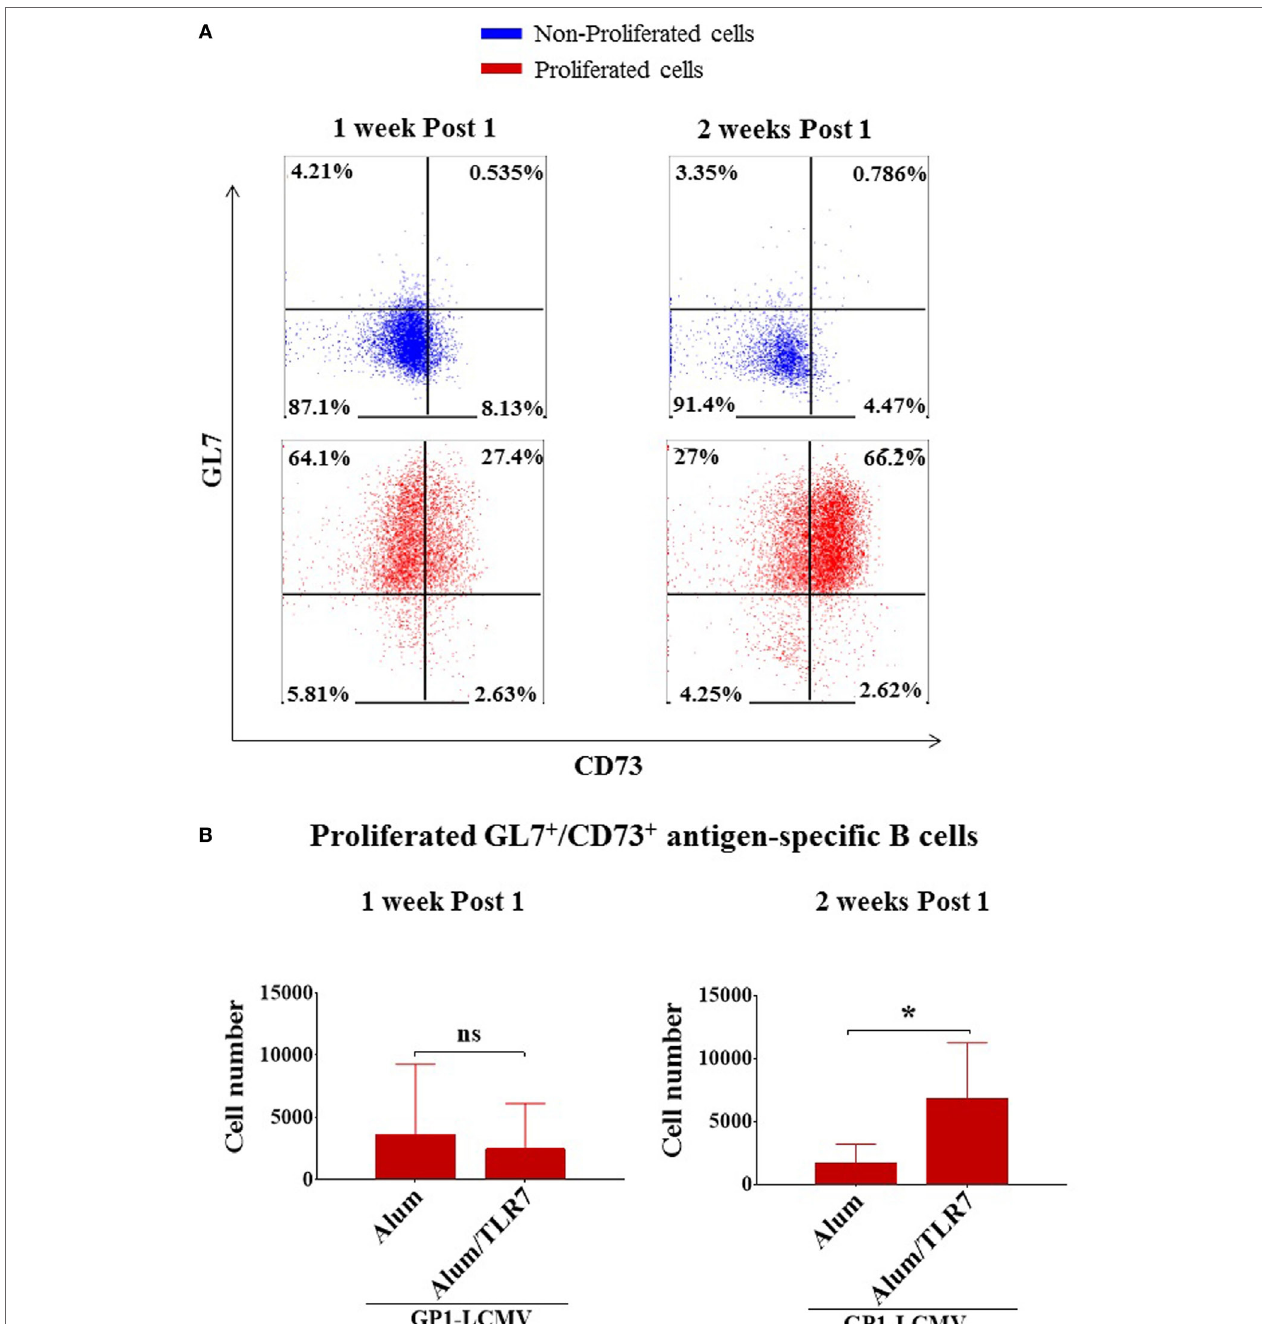
FigUre 3 | Alum-toll-like receptor (TLR)7 enhances the expansion of memory B cells. (a) Representative flow cytometry dot plots for GL7 and CD73 expression by non-proliferated (upper panels, blue dot plots) versus proliferated (lower panels, red dot plots) antigen-specific B cells 1 week and 2 weeks after immunization with antigen adjuvanted with either Alum or Alum-TLR7. (B) Bar graphs report the total number of GL7 + /CD73 + antigen-specific memory B cells within the draining lymph nodes from mice immunized with glycoprotein 1 of lymphocytic choriomeningitis virus (GP1-LCMV) formulated with Alum or Alum-TLR7, 1 week (left panel) and 2 weeks (right panel) after the treatment. Bar graphs plot the average results, with SD, of five independent experiments. Statistics: Mann–Whitney two-tailed test: * P < 0.05.